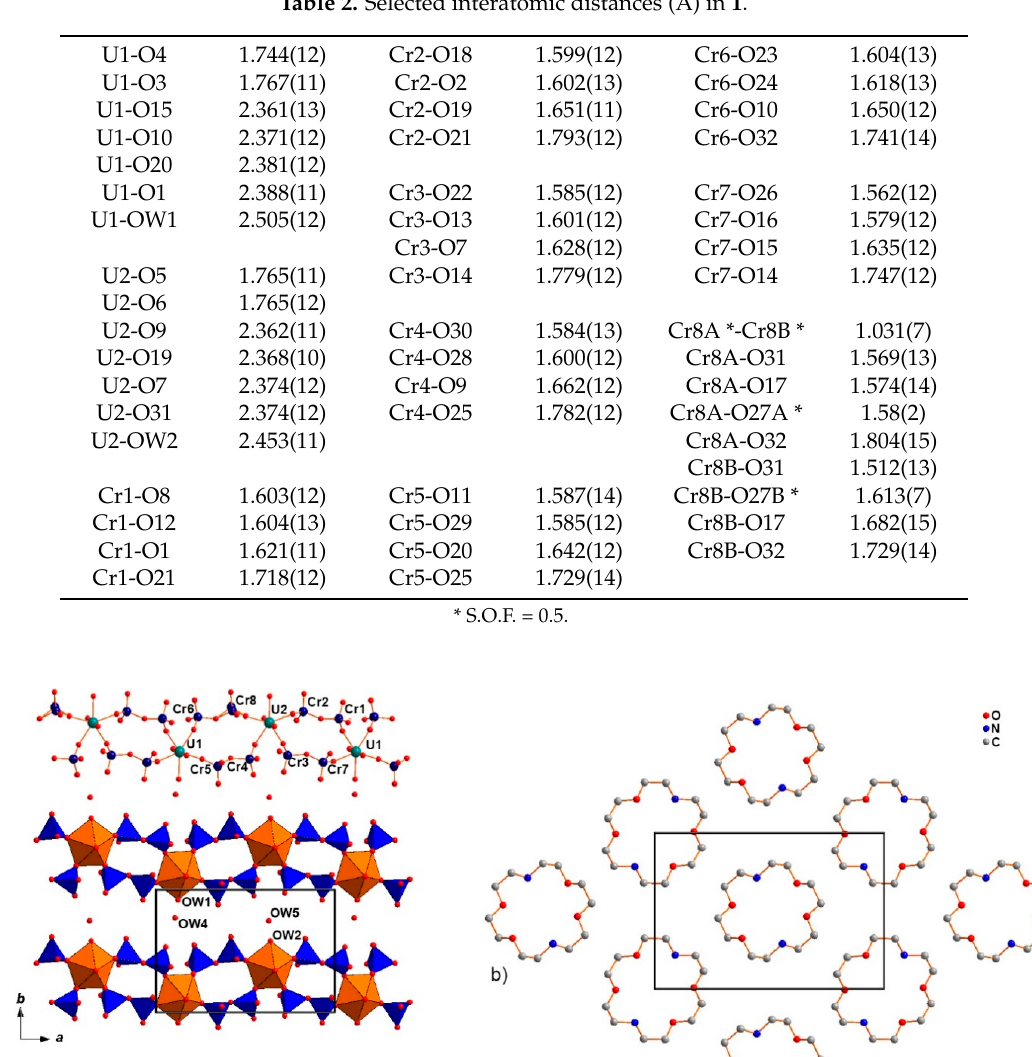
Table 2. Selected interatomic distances (Å) in 1 .